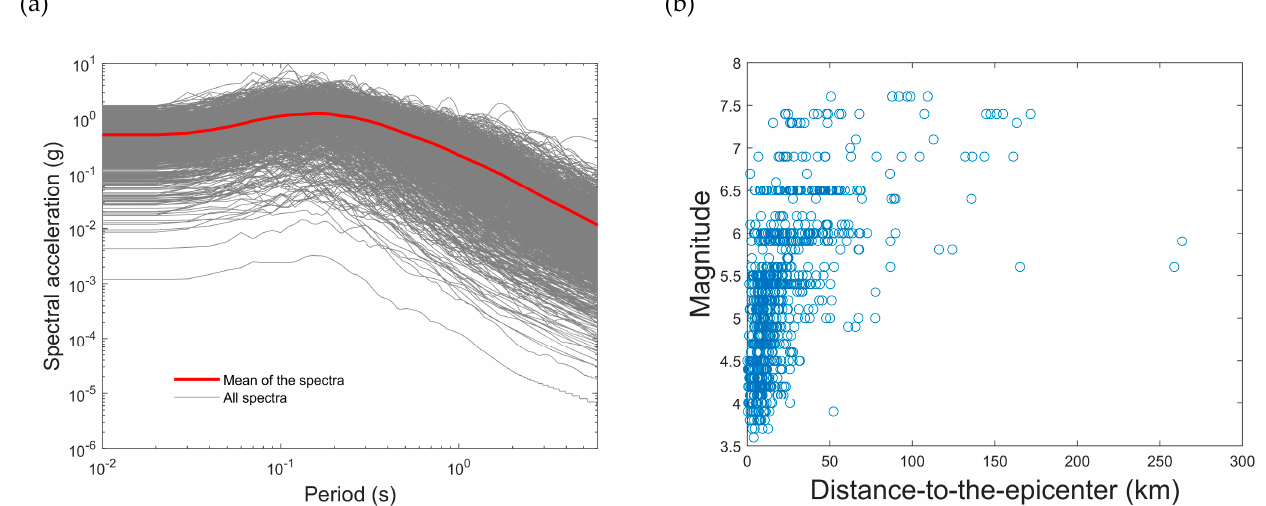
Figure 3. ( a ) Acceleration response spectra of the selected and scaled ground motion records; ( b ) magnitude and distance-to-the-epicentre.